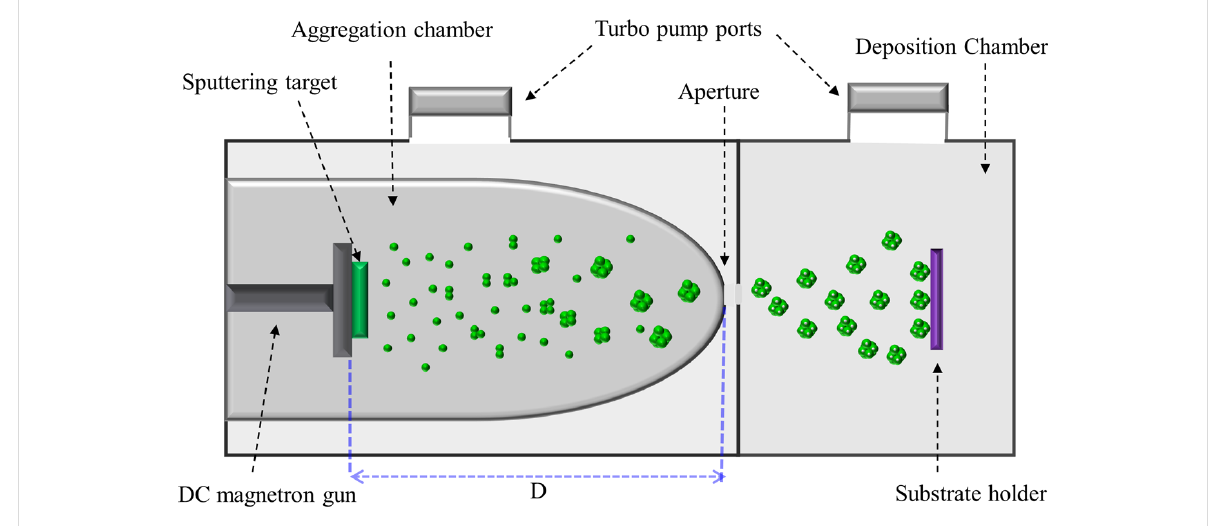
Figure 12: Schematic of the inert-gas condensation system used for nanoparticle growth.